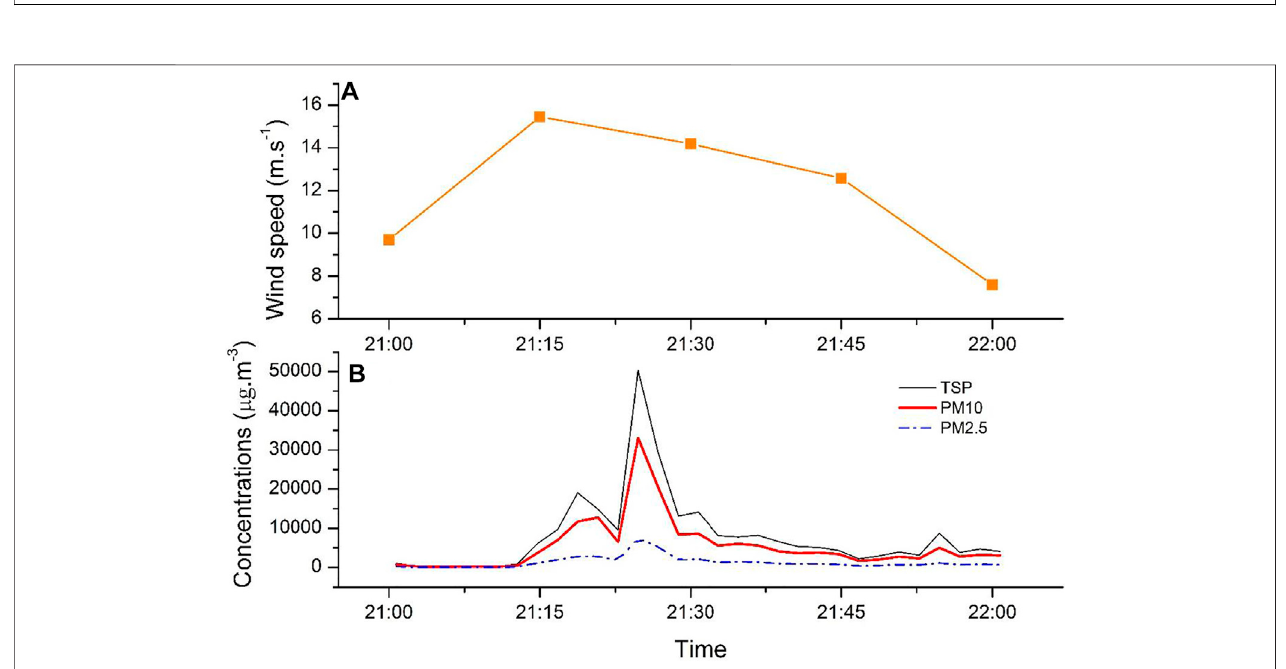
FIGURE 8 | Wind speeds at the height of 2 m (A) and dust concentrations (B) changing with time in an extreme dust episode on 21 February 2012.